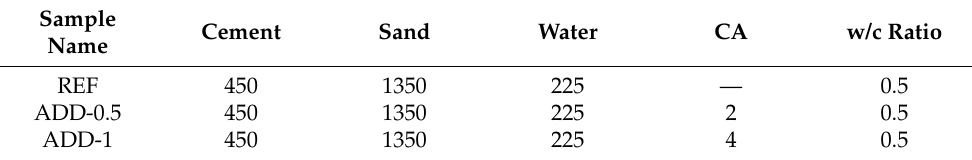
Table 1. Mortar mix proportion of the studied samples (in